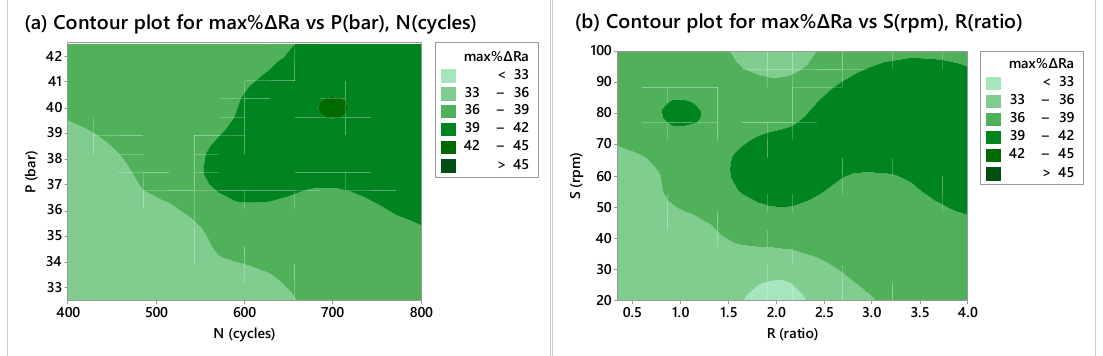
Figure 7. Contour plots for examining the effects of independent variables for controlling the rotational-magnetorheological abrasive flow nano-finishing process, with reference to experimental results presented in [4], ( a ) for max%Δ Ra vs. P (bar), N (cyles); ( b ) for max%Δ Ra vs. S (rpm), R (ratio).